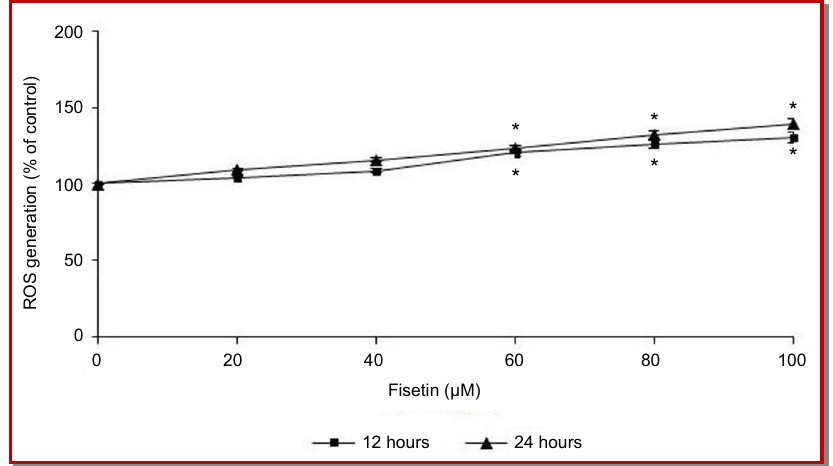
Figure 6. Influence of fisetin on intracellular ROS generation in U-2 OS cancer cells Values are represented as mean ± SD; n=3. *represents p<0.05 compared with control as determined by one-way